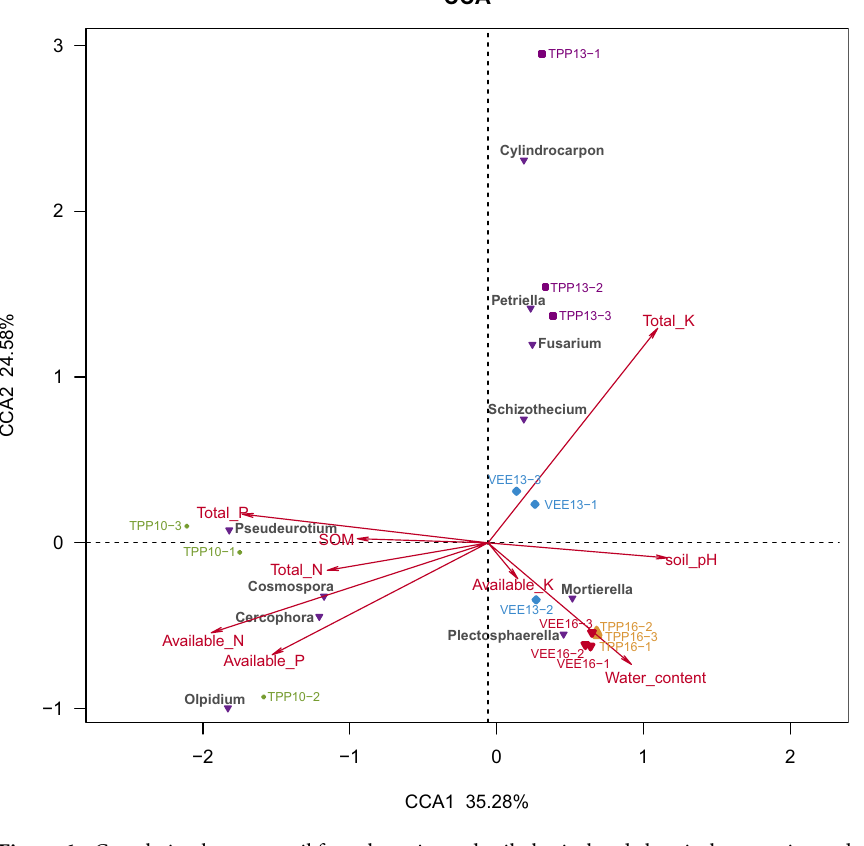
Figure 6. Correlation between soil fungal species and soil physical and chemical properties under different planting patterns and time scales. The abbreviation “SOM” in the figure means “soil organic matter”.